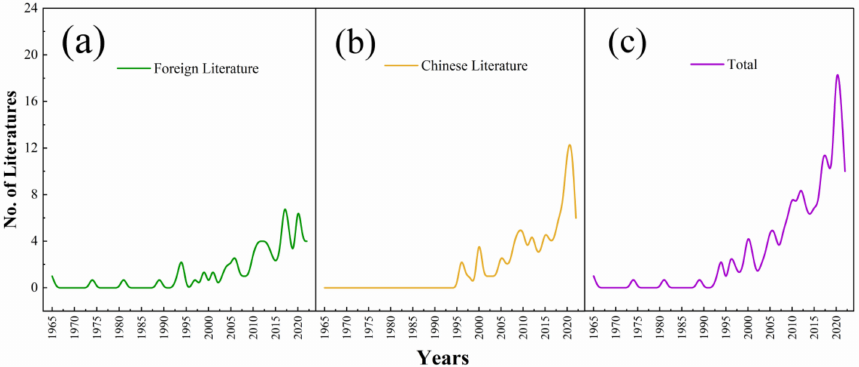
Figure 3. Trends in the annual distribution of literature related to soil mulching and soil erosion. ( a ) The trend of the literature in the WoS database; ( b ) the trend of the literature in the CNKI database; ( c ) the trend of the total literature in both databases. The deadline is 30 June 2022.